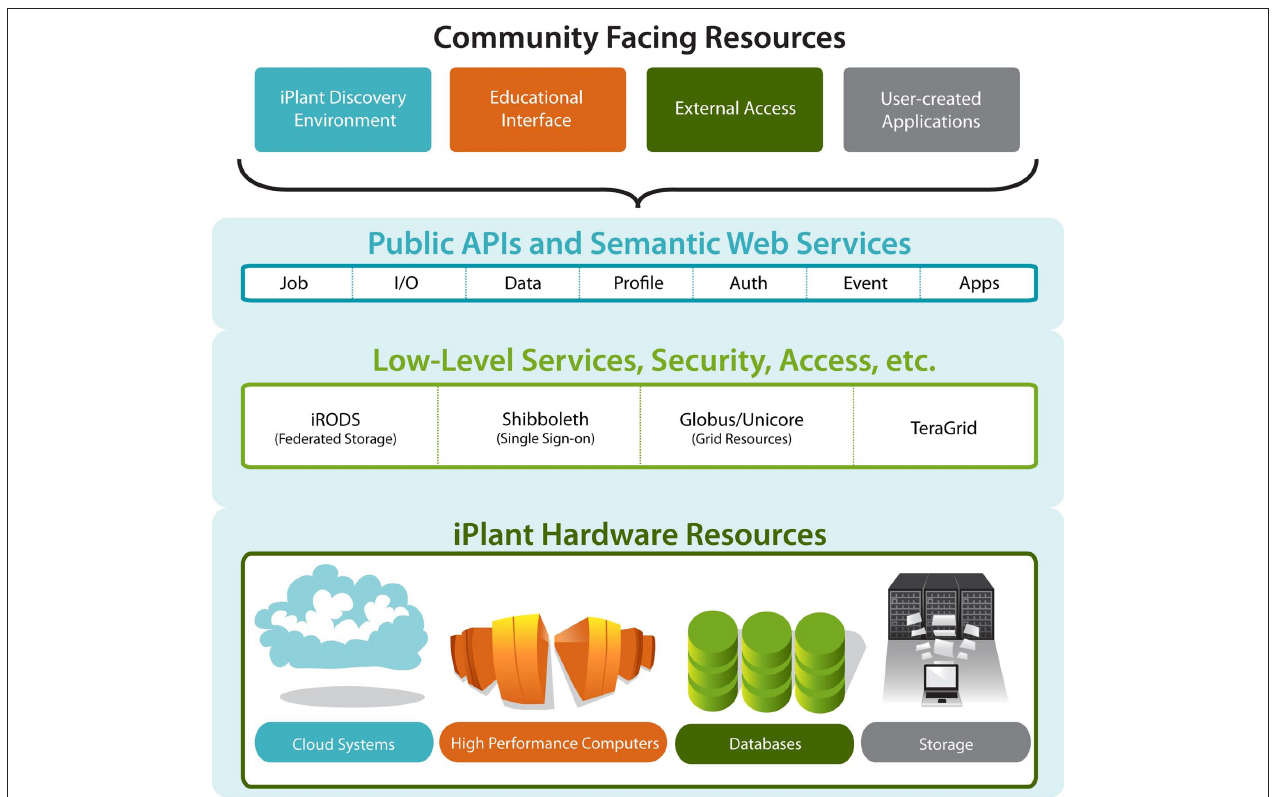
FIgure 2 | An illustration of the multilayered iPlant cyberinfrastructure platform. The three primary building blocks of the iPlant CI are depicted with overlying community access options. Individual blocks are comprised of distinct software and hardware components that collectively provide the integration and